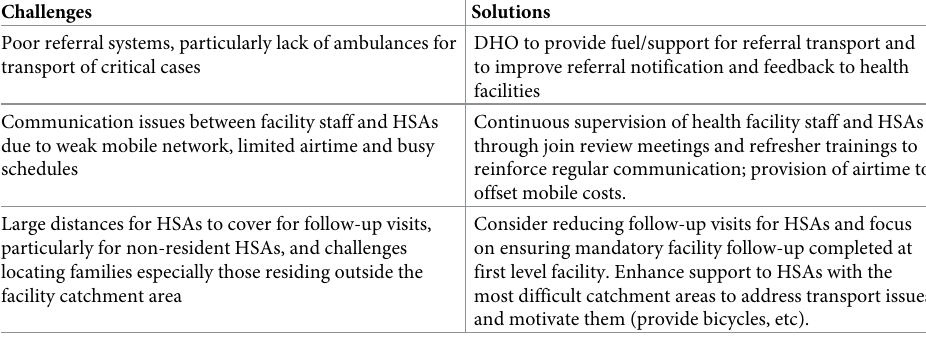
Table 5. Main challenges associated with implementation of the WHO guideline and potential solutions men- tioned by health facility staff and